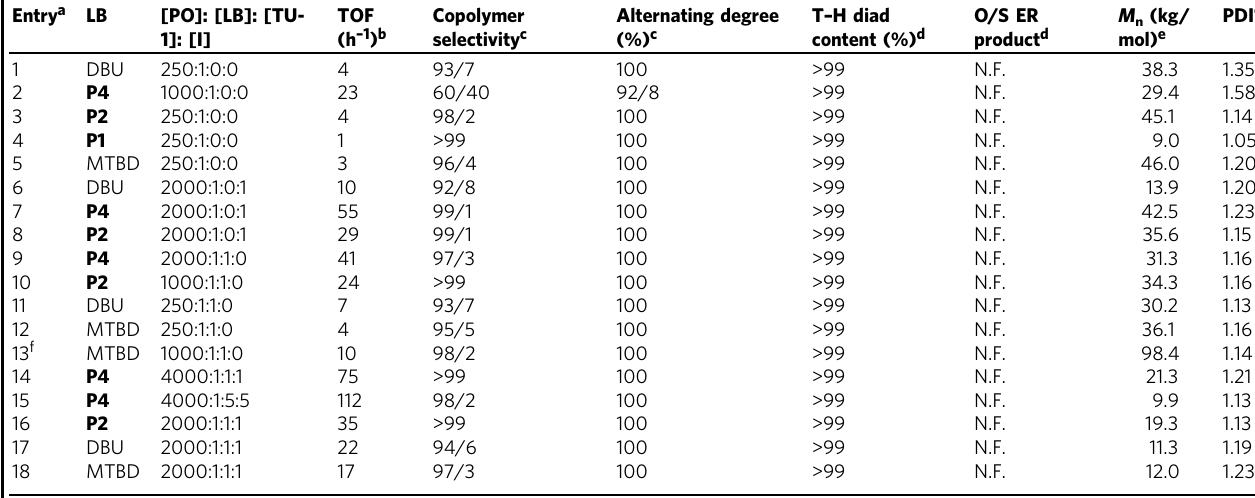
Table 1 COS/PO copolymerization catalyzed by TU-1/organic base pairs at 25 °C Entry a